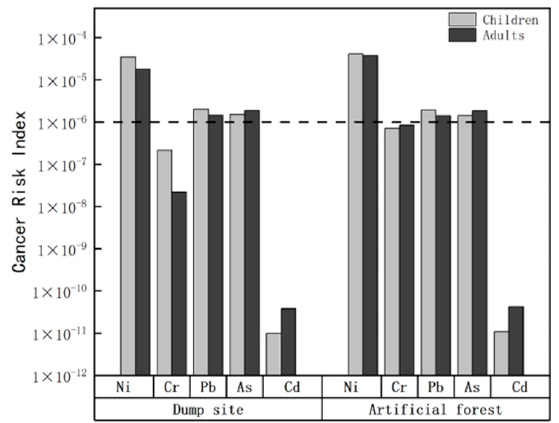
Figure 5. Cancer risk index of different functional areas.